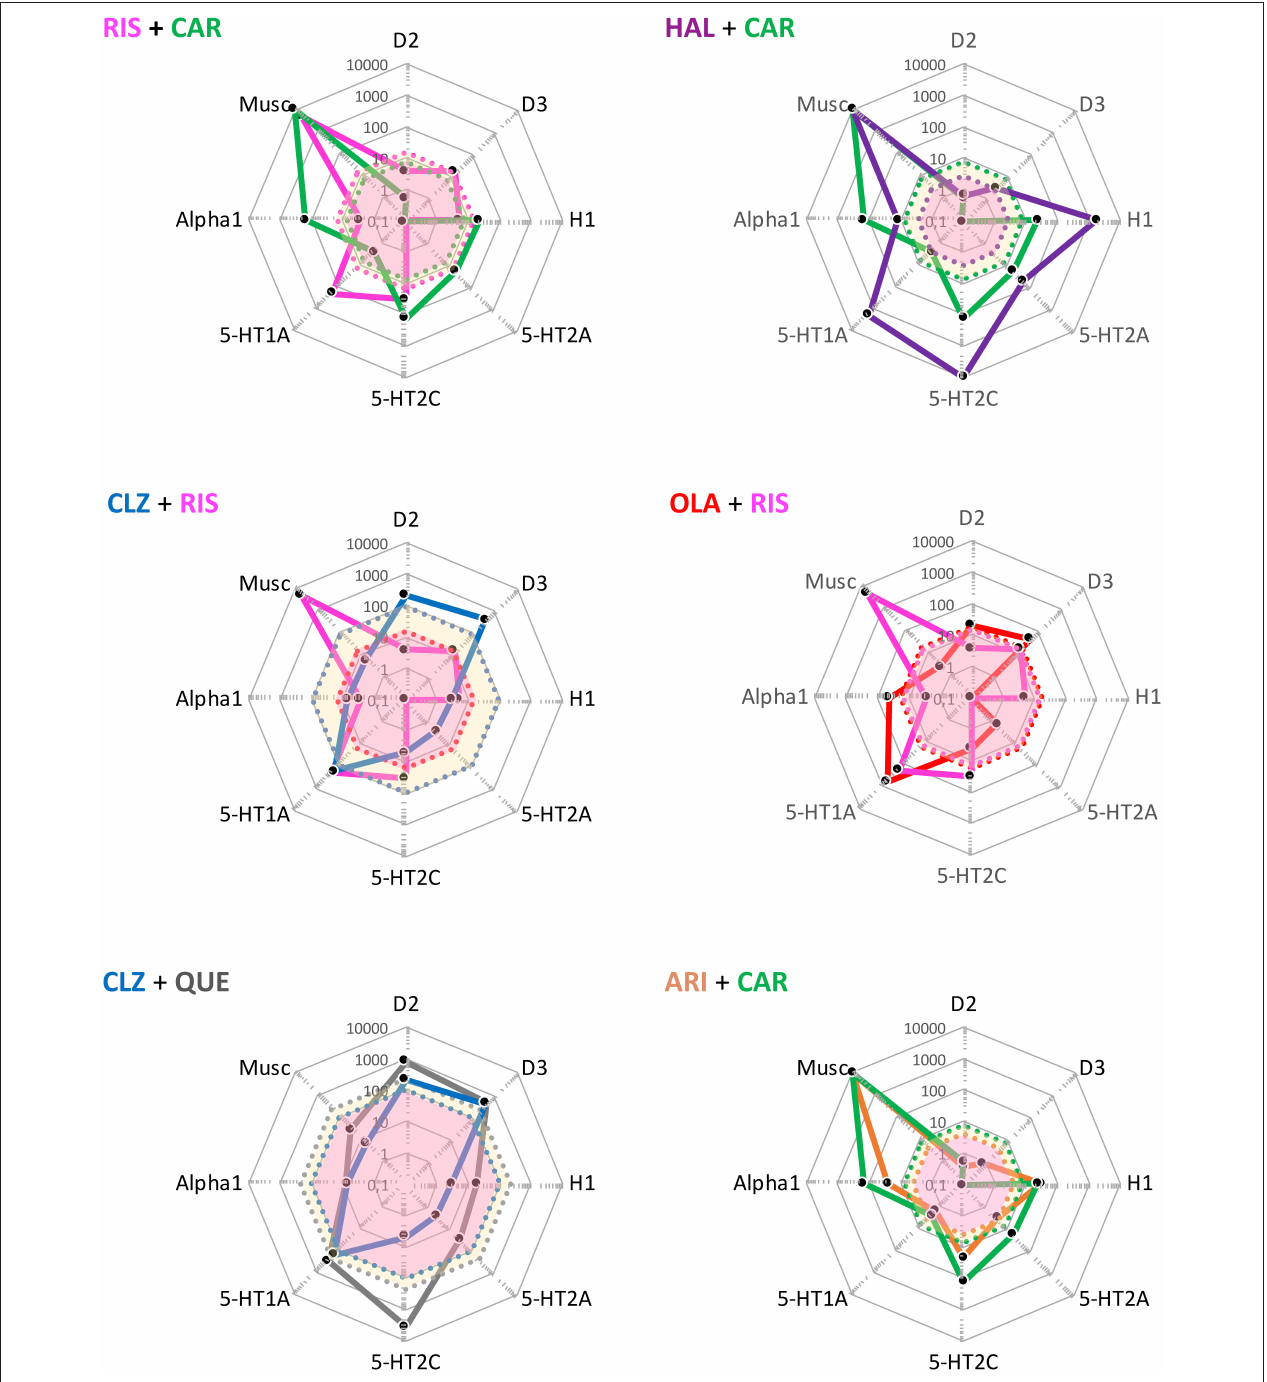
FIGURE 6 | Some theoretically suboptimal, less preferable—or even futile—APP target combination examples based on FGA, SGA, and TGA. Shown are target profiles of APP combination examples based on CLZ, RIS, HAL, CAR, QUE, OLA, and ARI displayed in a cobweb design. For further explanations, see legend